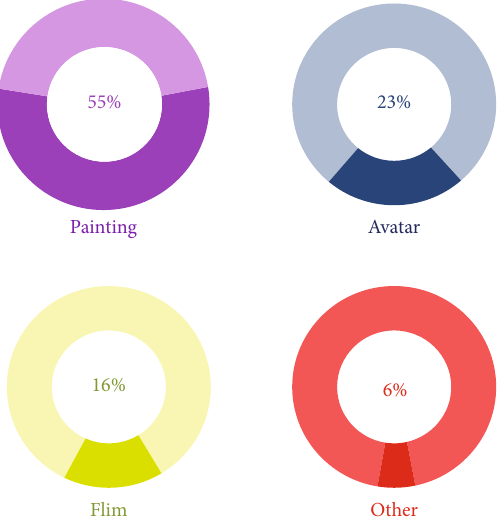
Figure 3: Proportion of di ff erent types of NFT artworks circulating in the trading market.